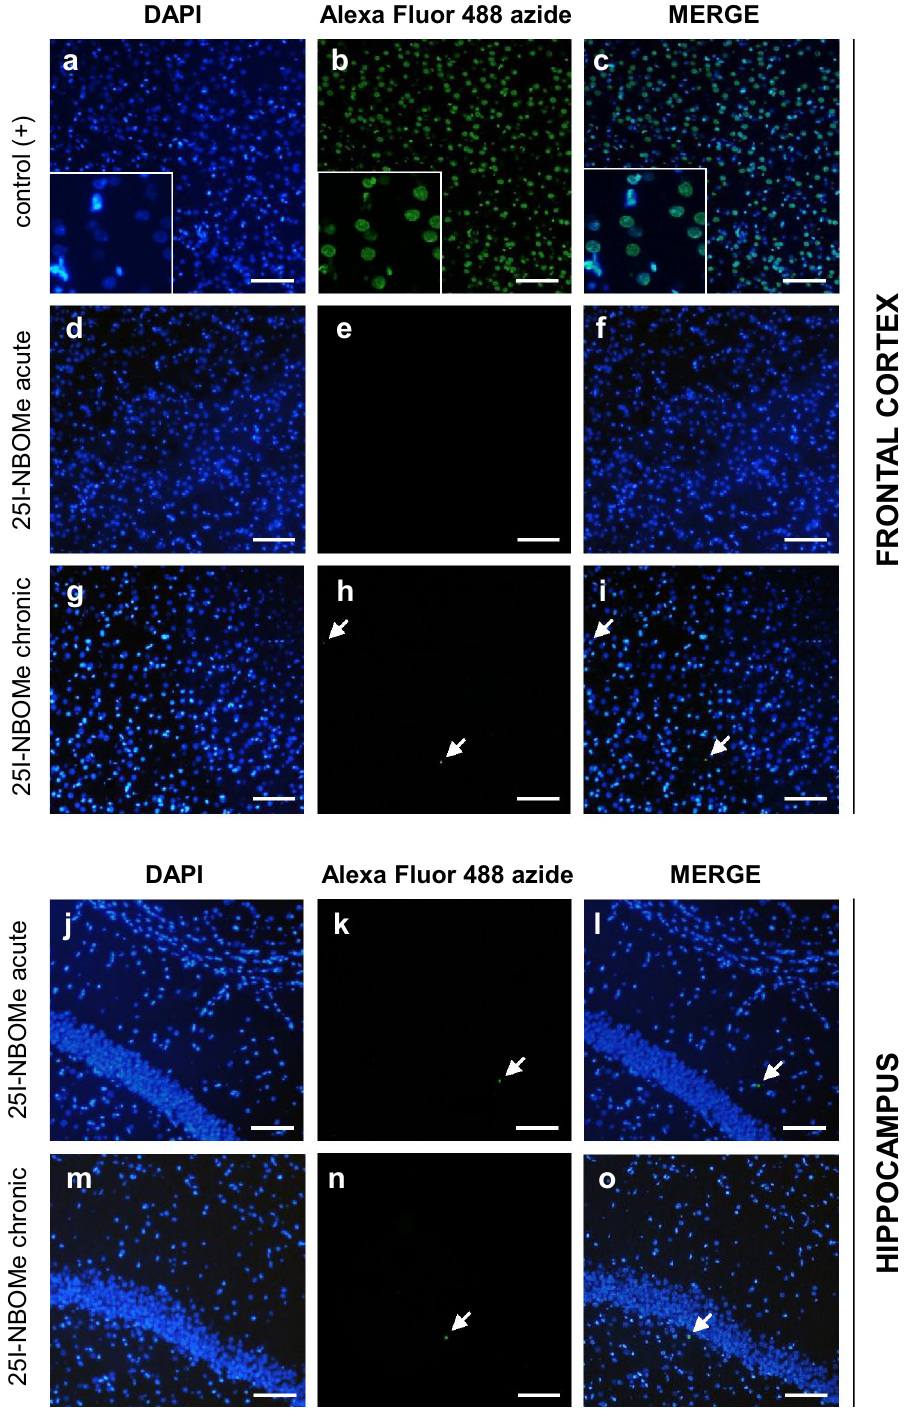
Figure 6. Apoptosis measured by TUNEL assay in rats treated with a single (0.3 mg/kg; d – f , j – l ) or repeated (0.3 mg/kg × 7; g – i , m – o ) dose of 25I-NBOMe (n = 4) in the rat frontal cortex and hippocampus. The brain slices treated with DNAse being a positive control are shown in a, b, and c. The arrows show apoptotic nuclei indicated by green ( b , e , h , k , n ). Blue spots represent nuclei stained by DAPI ( a , d , g , j , m ), and merged images are shown in ( c , f , i , l , o ) (scale bars = 100